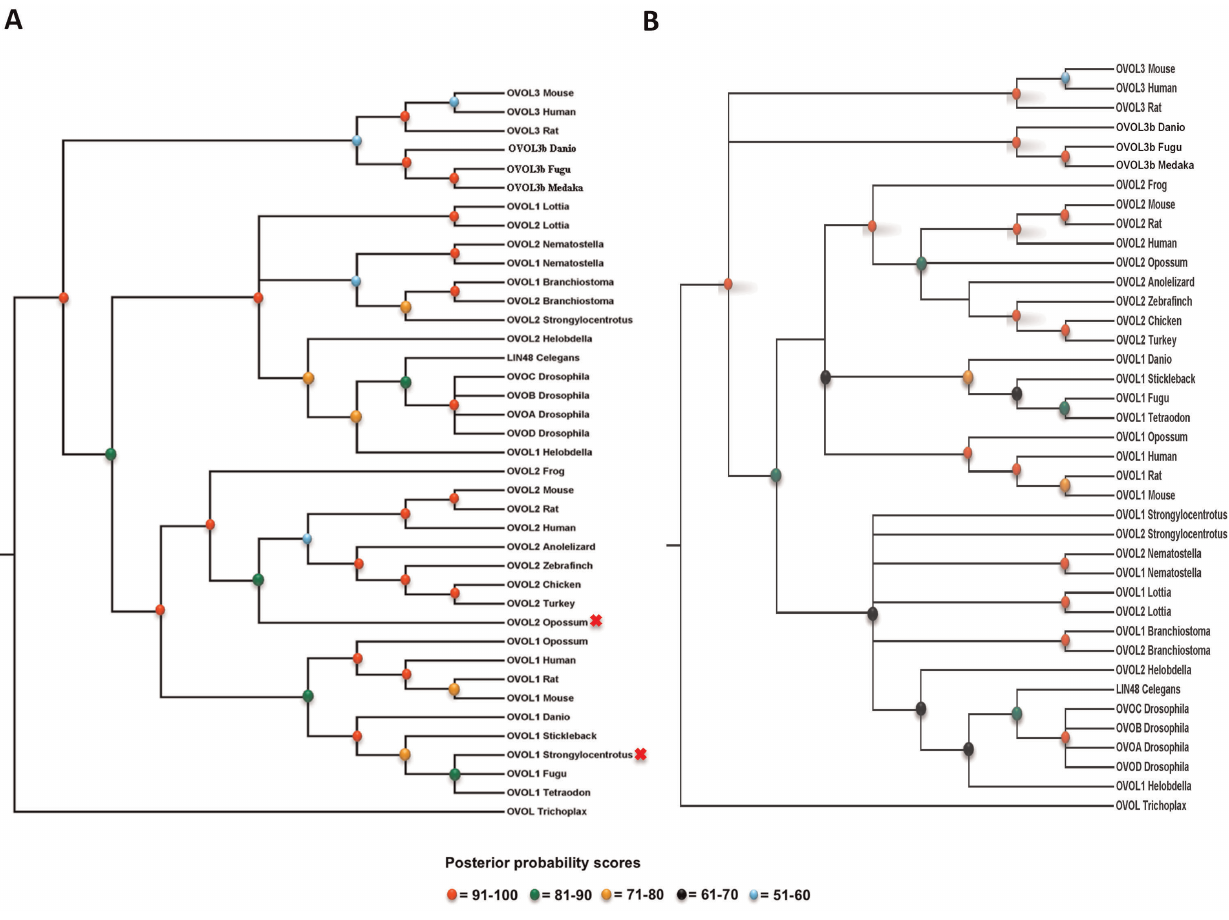
Figure 7. Phylogenetic history of OVOL proteins using the Bayesian method. A. Full-length OVOL proteins. B. Selected region of OVOL proteins. Posterior probabilities scores are depicted by various color balls. The placozoan OVOL protein (e_gw1.4.509.1) was used as the outgroup in this phylogenetic tree. Red x indicates sequence position, which did not accord with species phylogeny. BFL: B. floridae (lancelet), SPU: S. purpuratus (sea urchin), NVE: N. vectensis (sea anemone), HRO: H. robusta (annelids), LGI: L. gigantean (molluscs) and TAD: T. adhaerens